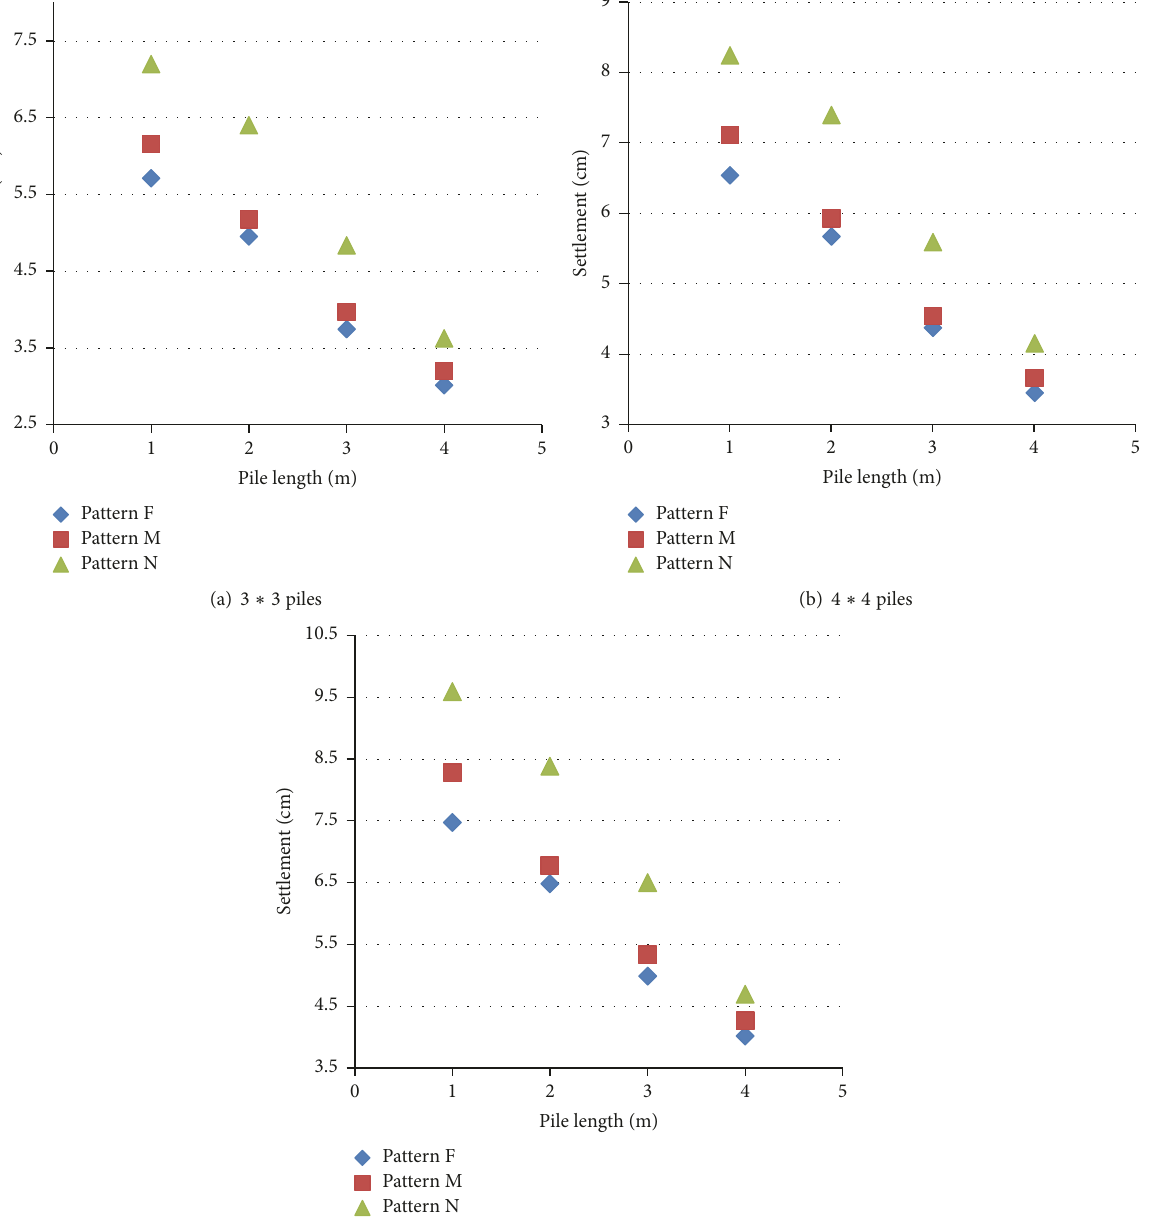
neuron’s weights and obtain accurate outputs. This second phase is called backpropagation phase